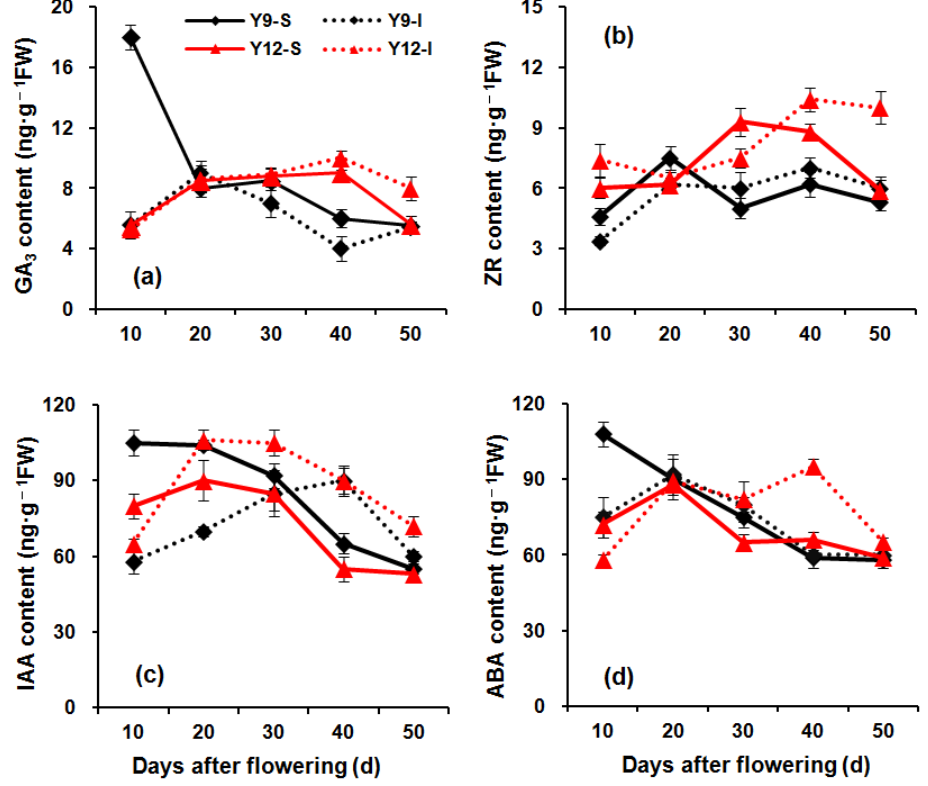
Figure 7. Changes in hormone contents in rice grains after flowering: ( a ) GA 3 contents; ( b ) ZR contents; ( c ) IAA contents; ( d ) ABA contents. Error bars denote ± standard deviation ( n = 3).